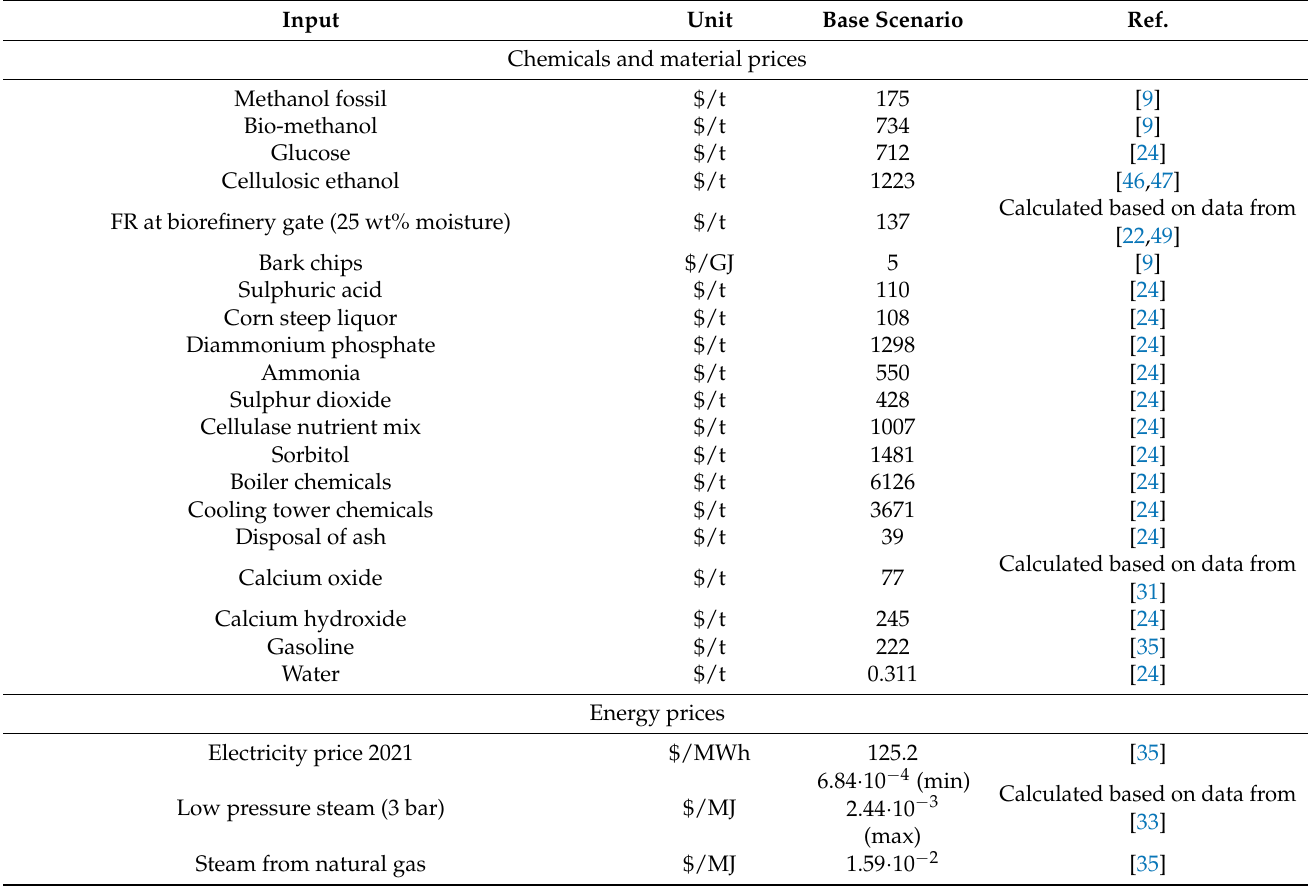
Table A5. Materials, chemicals and energy prices.